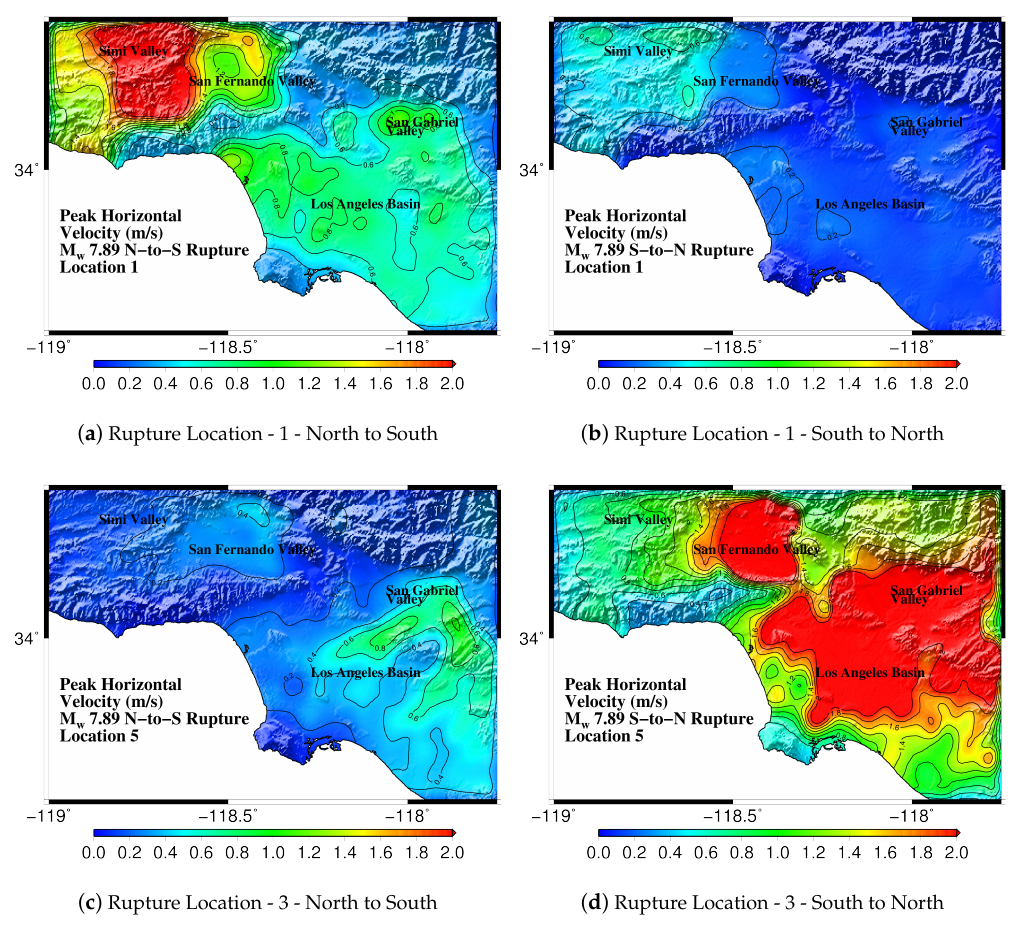
Figure 9. Directivity effect: Comparison of simulated peak horizontal velocity from north-to-south and south-to-north ruptures of the magnitude 7.89 scenario earthquake at locations 1 ( a , b ) and 5 ( c , d